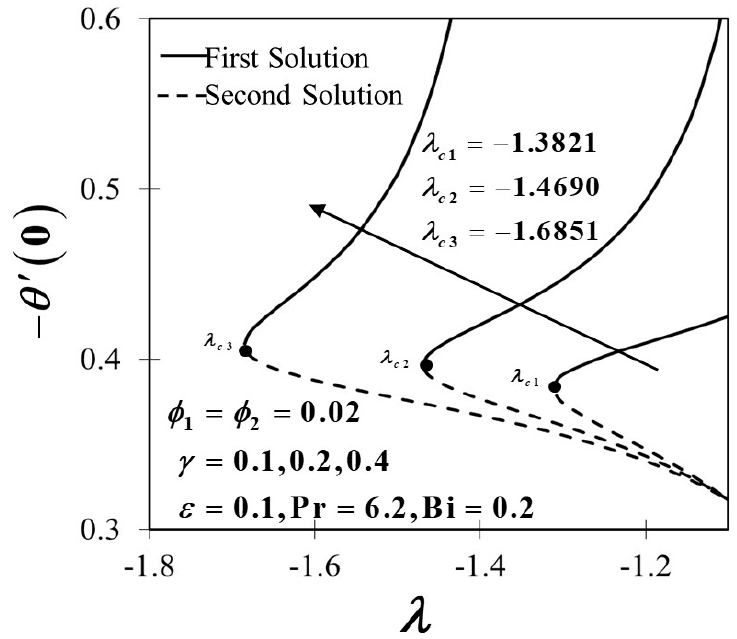
Figure 3. Variants of − θ (cid:48) ( 0 ) towards λ with γ =